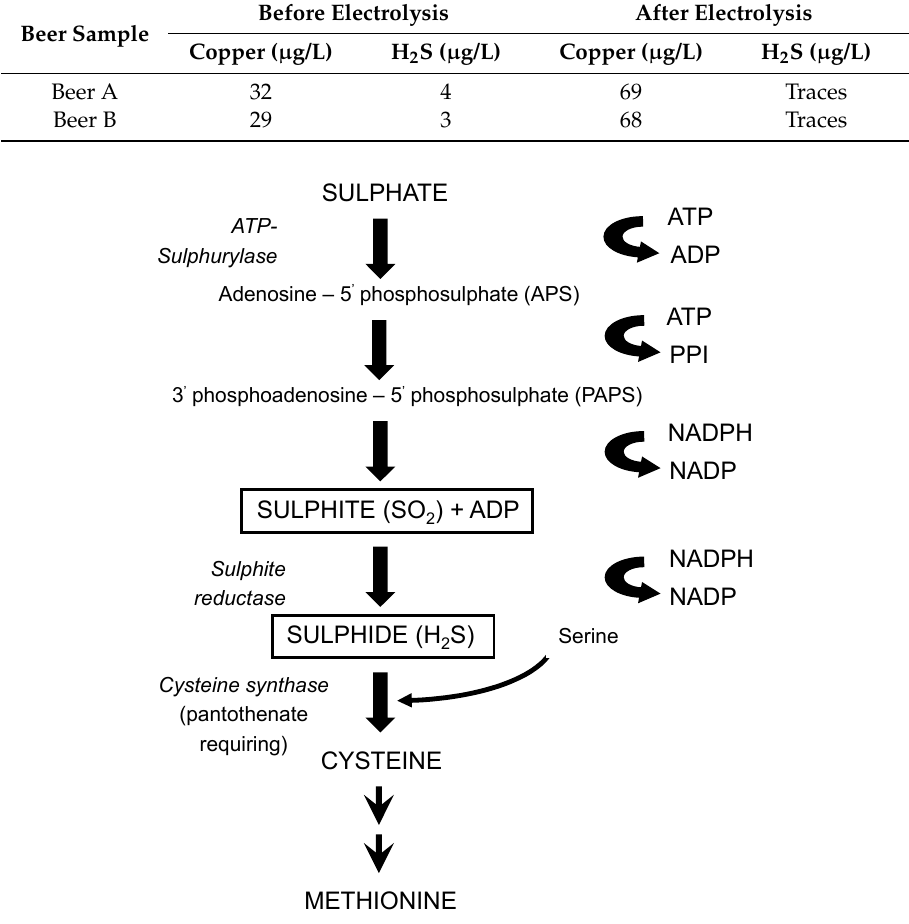
Figure 21. Binding of bisulphite to carbonyls.